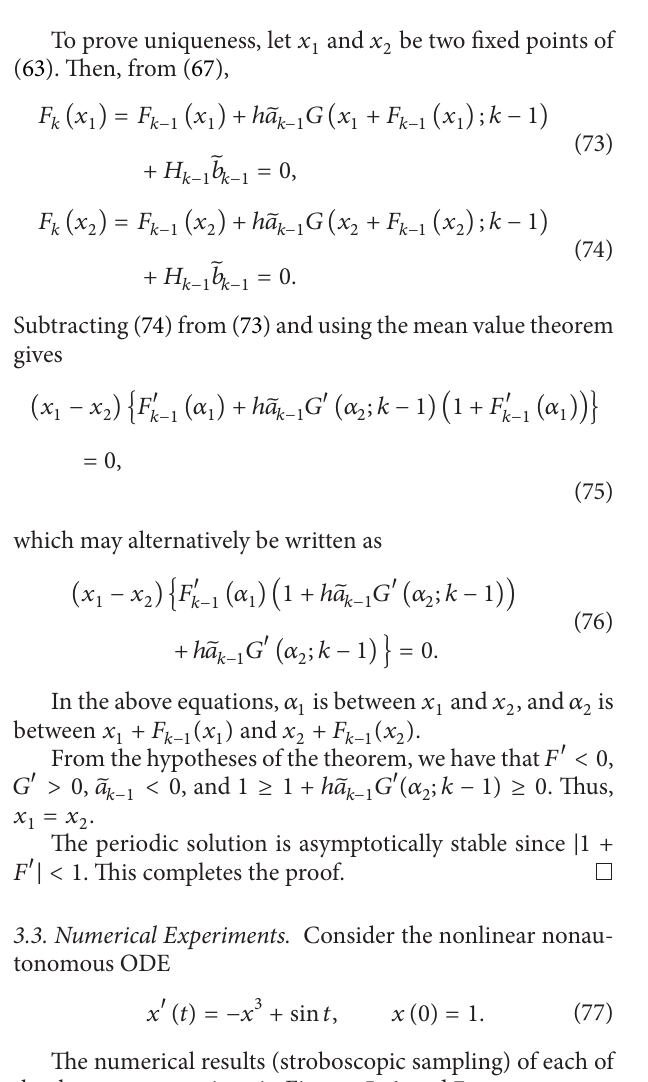
Figure 6: Numerical results for (77) with 𝑐 1 = 1/2 . 𝑘 = 20 .